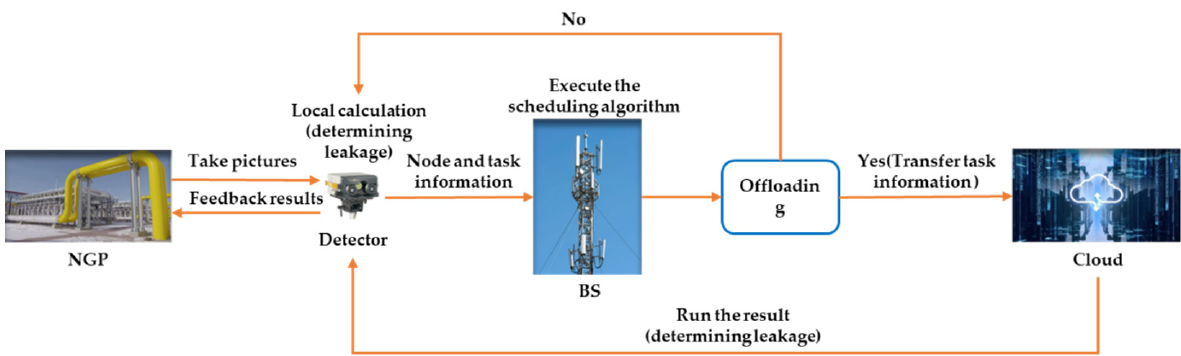
Figure 1. Workflow of edge computing in natural gas pipeline detection.